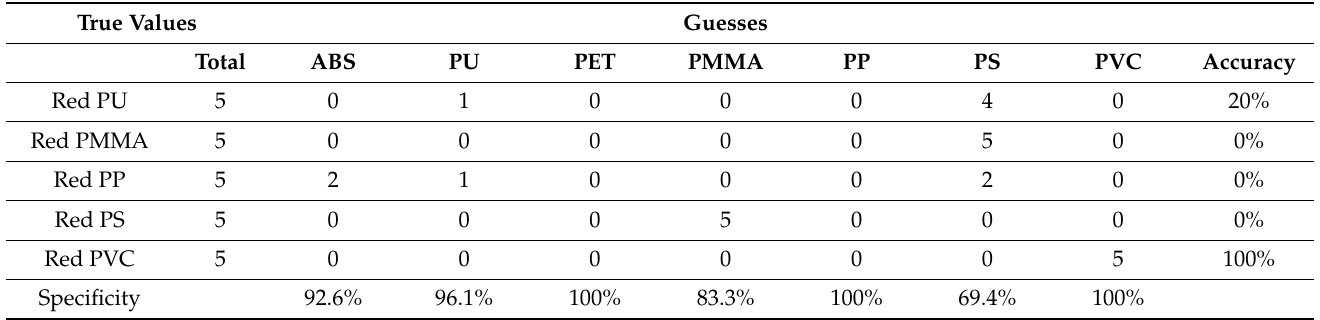
Table 4. Confusion matrix of the test data recorded with red samples with calculated accuracy (sensitivity) and specificity of each material, when pulse salvo classification is